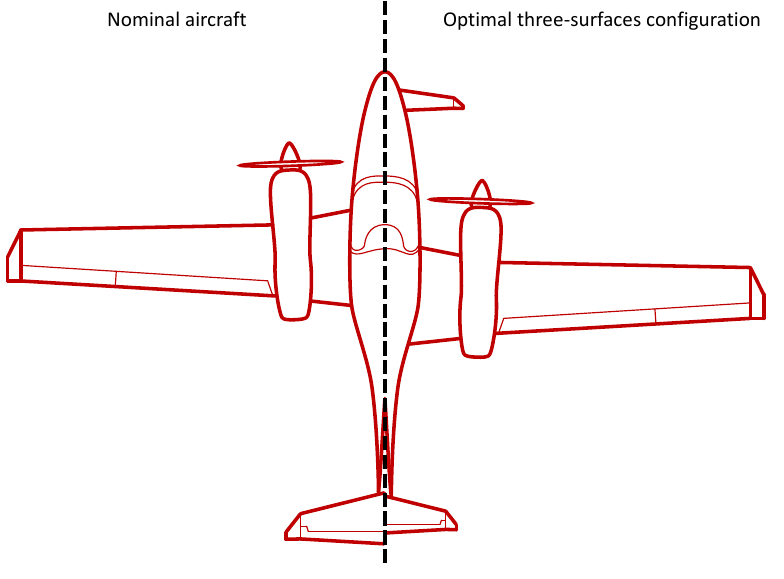
Figure 5. Sketch of the nominal DA42 airplane ( left ) and optimal three-surface equivalent version ( right